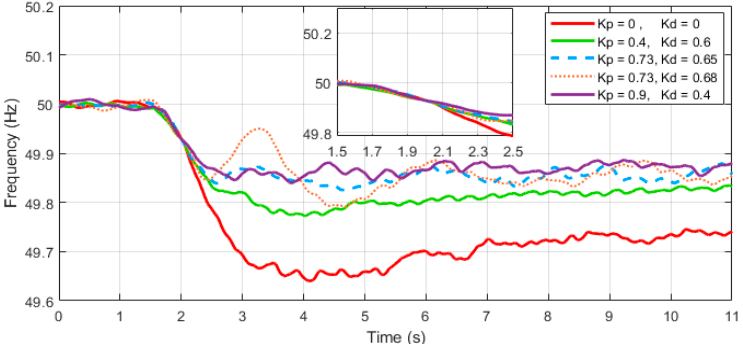
Figure 5. Selection of controllers gains kp and kd for the system under study.